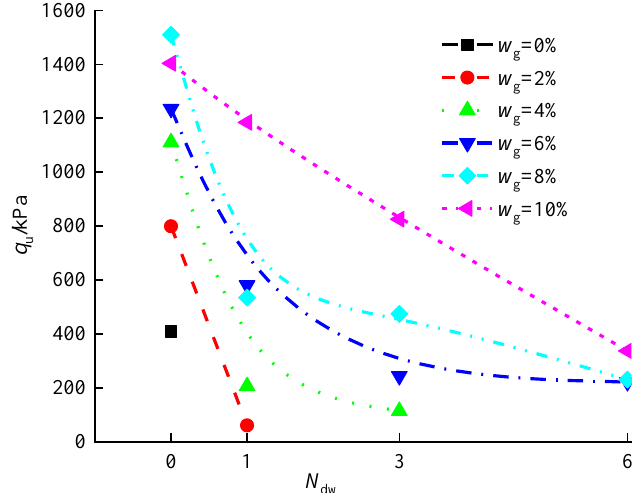
0 Figure 21. Effect of different dosages of PZ-1 curing agent on dry-wet Figure 21. Effect of different dosages of PZ-1 curing agent on dry – wet cycle.